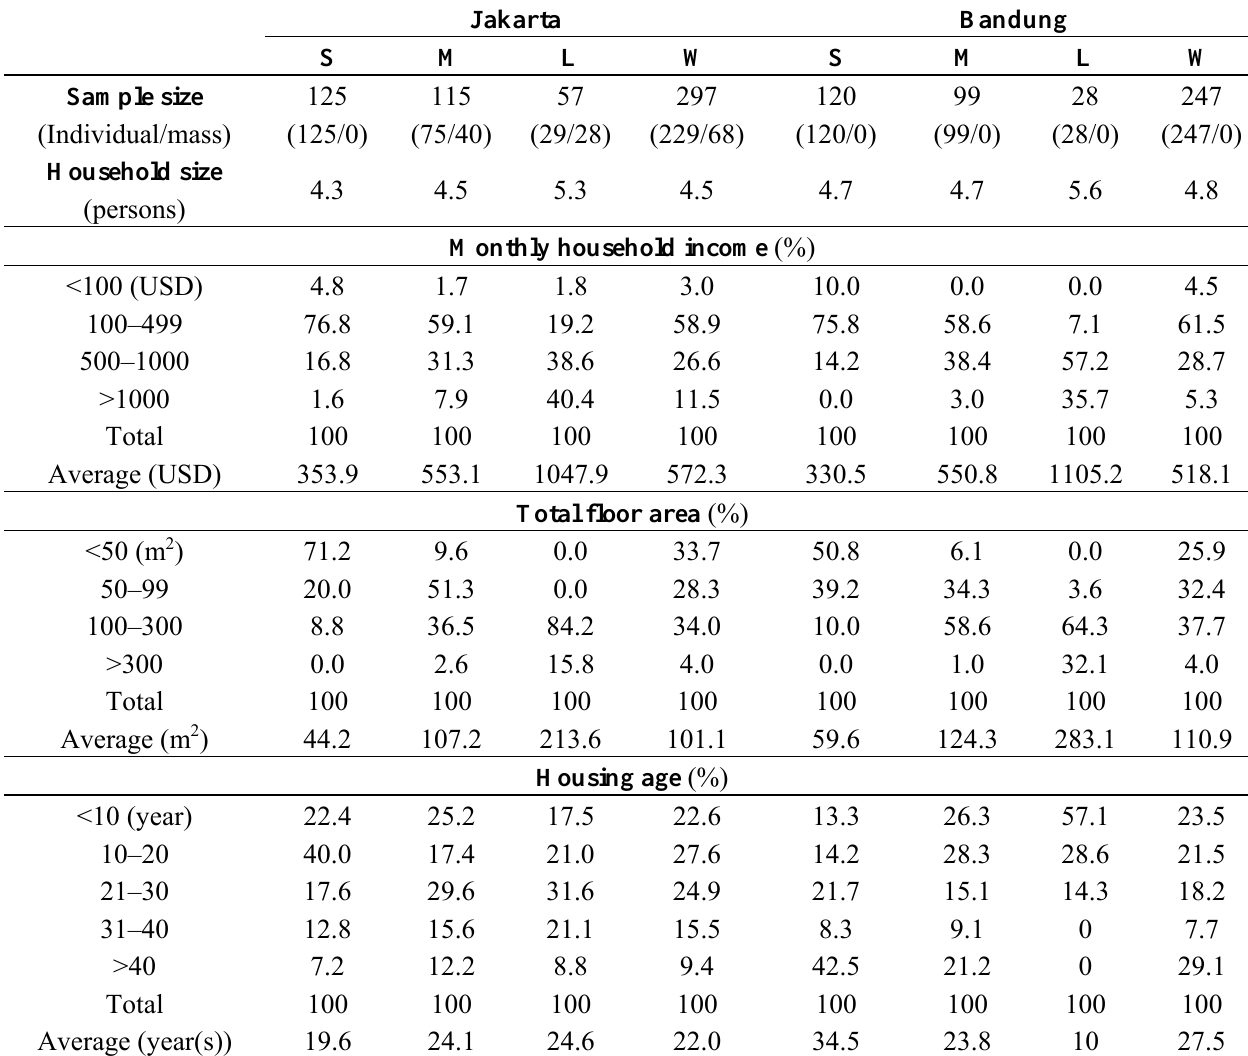
Table 1. Brief profile of sample houses in Jakarta and